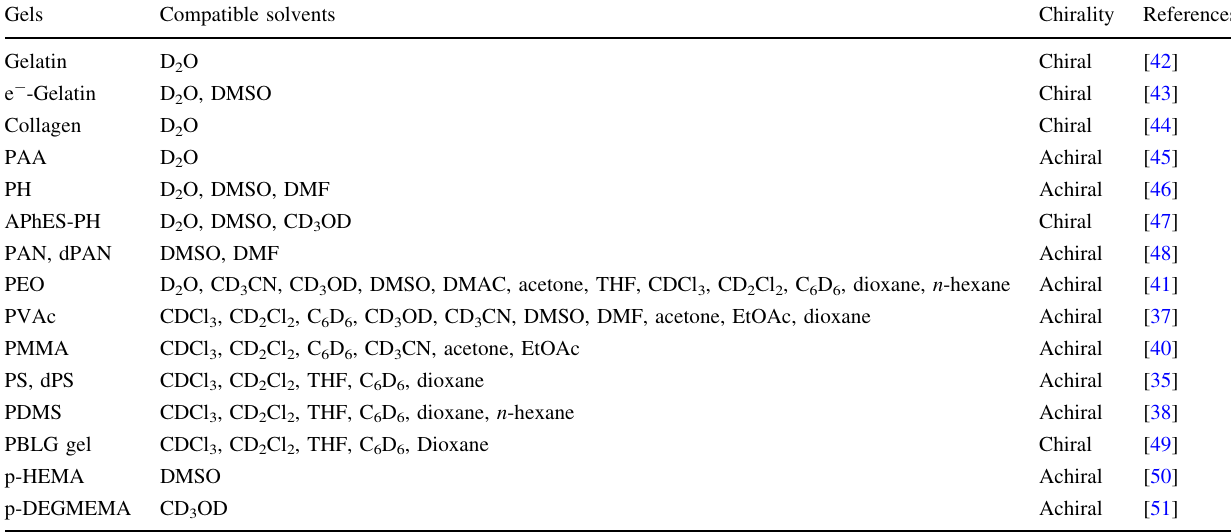
Table 2 Cross-linked polymer gels and their solvent compatibilities and properties Gels